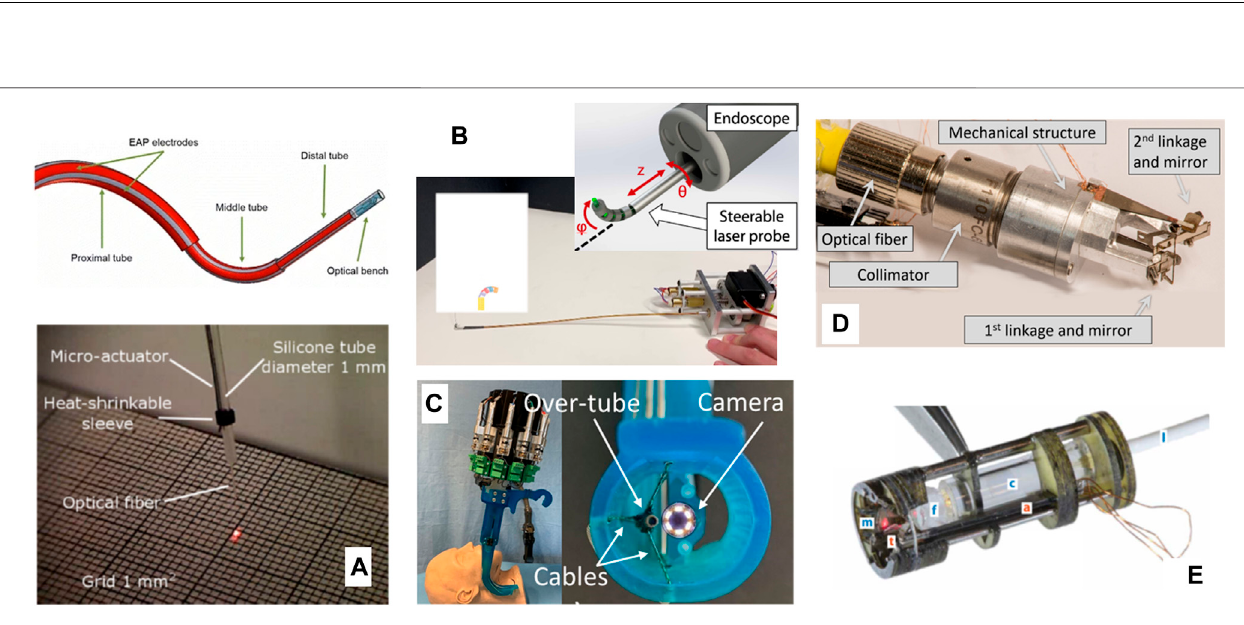
FIGURE 4 | Magnetically actuated laser scanners for endoscopic microsurgery. (A) Concept (B) Prototype based on a standard silicon optical fi ber (Acemoglu et al., 2019). (C) Prototype based on a CO 2 laser waveguide (Acemoglu and Mattos, 2018).